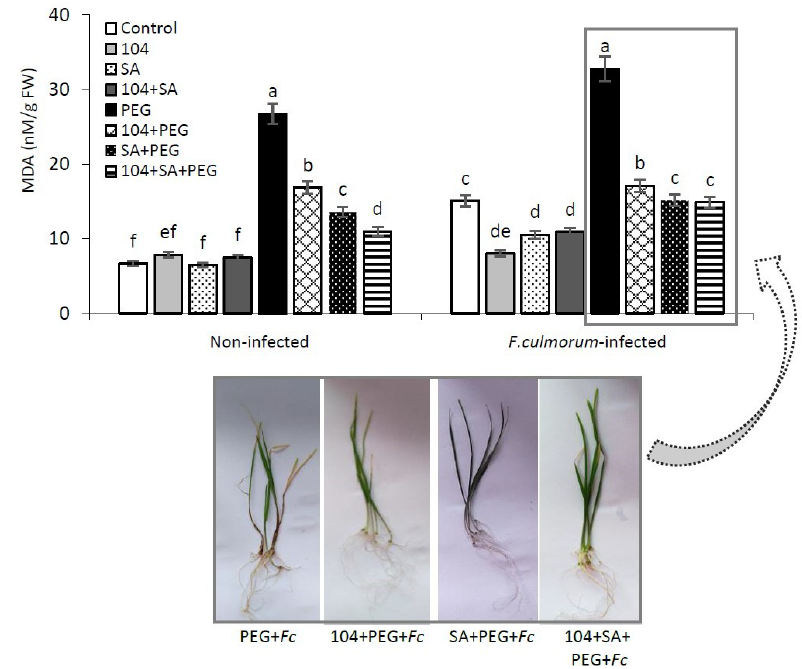
Figure 7. Effect of B. subtilis 10–4 (104) (10 5 CFU mL −1 ), salicylic acid (SA) (0.05 mM), and composition of B. subtilis 10–4 + SA (104+SA) on the concentration of malondialdehyde (MDA) in non‐infected by F. culmorum (non‐infected) and infected by F. culmorum ( F. culmorum ‐infected) wheat plants under normal and combined drought stress (PEG) conditions. Fourteen‐day‐old seedlings; drought stress (12% PEG) exposure time—11 days; time after infection with F. culmorum —10 days. Fc — F. culmorum . The error bars show the average of three replicates ± SEM. Different letters indicate a significant difference between the average values for p <